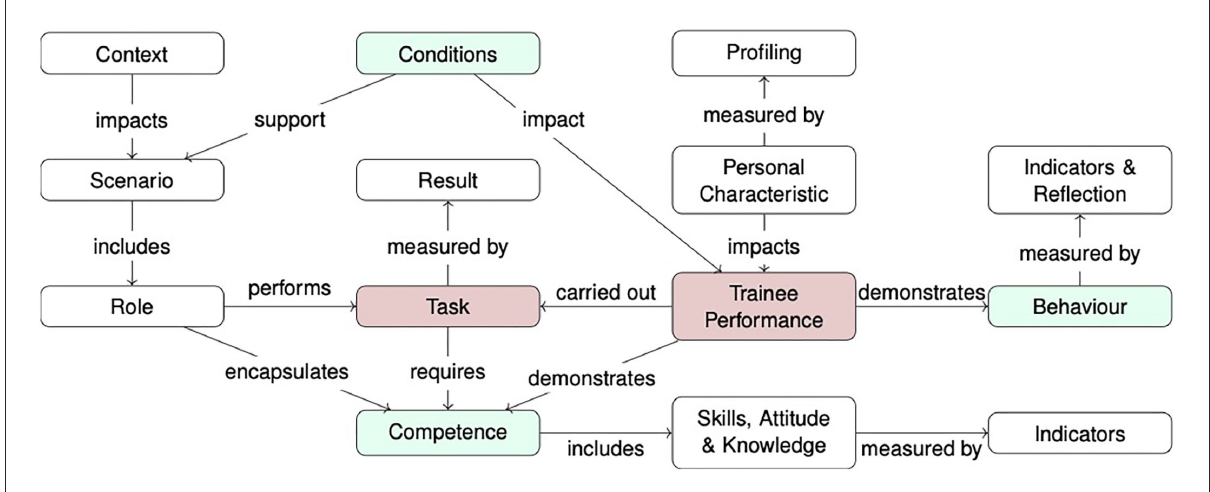
FIGURE1 The trainee competence model within the cybersecurity education ecosystem reflects the close-to-real environment of the cybersecurity workforce.